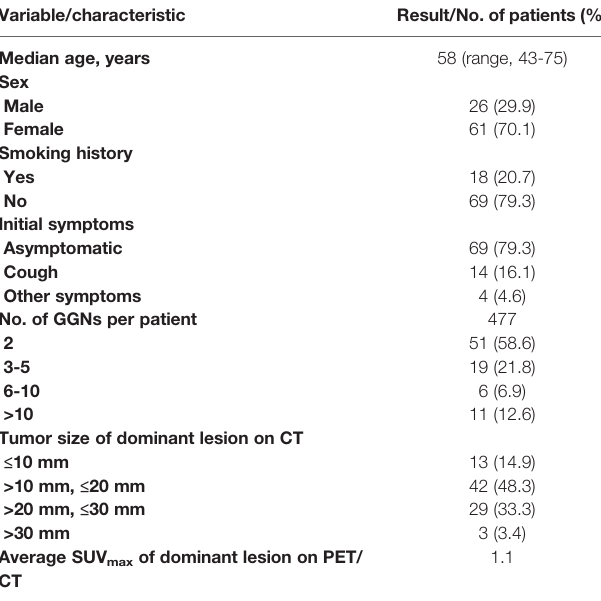
TABLE 2 | Pathological and molecular-biological characteristics of 87 patients. Variable/characteristic Result/No. of patients